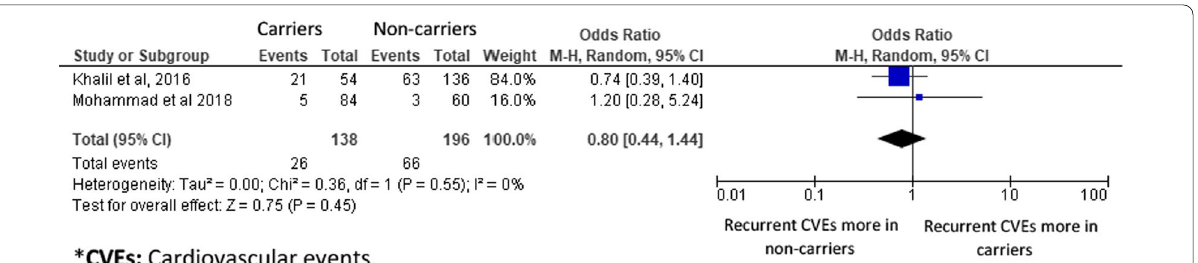
Fig. 4 Forest plot showing the frequency of recurrent CVEs among carriers and non-carriers of CYP2C19*17 mutation, and results of odds